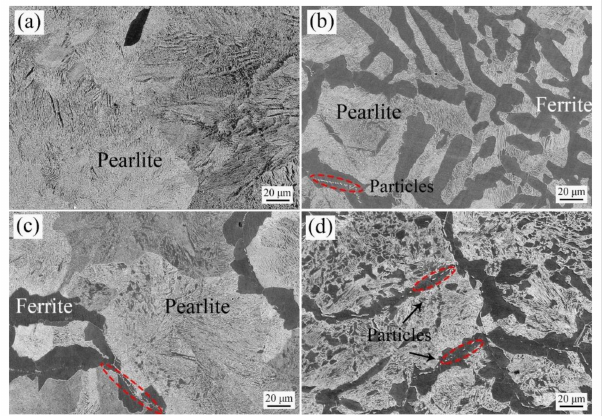
Figure 2. SEM micrographs of the cast steels with different (NbTi)C nanoparticles additions: ( a ) 0 wt.%; ( b ) 0. 13 wt.%; ( c ) 0. 16 wt.%; ( d ) 0. 66 wt.%,